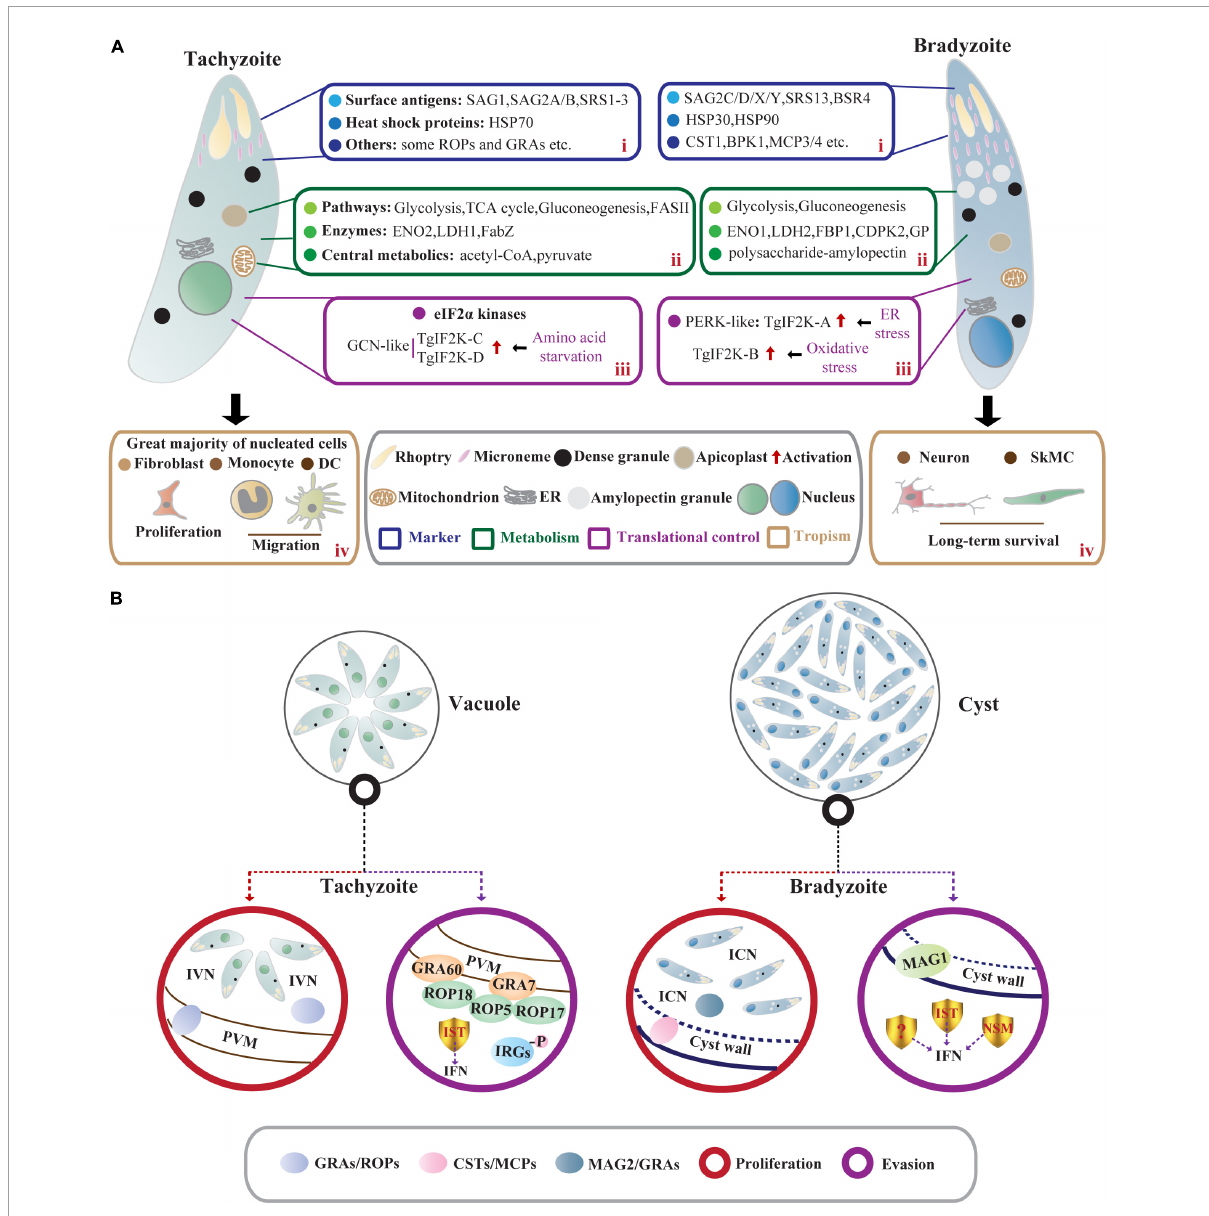
FIGURE1 Comparisons of T. gondii acute stage and chronic stage in intermediate hosts. (A) Characteristics of tachyzoites and bradyzoites. In intermediate hosts, the rapidly dividing tachyzoites and slowly growing bradyzoites differ in many characteristics, including (i) stage-specific markers; (ii) metabolism; (iii) translational control; and (iv) tropism. (i) The stage-specific proteins contain SAGs and HSPs as well as some membrane-associated proteins exported to PV membrane (ROPs and GRAs) and cyst wall (CSTs and MCPs). (ii) Central carbon metabolism (the glycolytic pathway and the tricarboxylic acid cycle) and gluconeogenesis allow intracellular tachyzoites to survive promiscuously. However, bradyzoites lack a functional TCA cycle and respiratory chain but accumulate abundant polysaccharide–AG in the cytoplasm. (iii) The eIF2 α phosphorylation regulated by TgIF2K-A and TgIF2K-B leads to the reprogramming of the transcriptome and initiation and maintenance of parasite latency. TgIF2K-C and TgIF2K-D have been reported to protect tachyzoite against amino acid starvation. (iv) The tachyzoites can infect almost all nucleated cells especially fibroblasts, and hijack monocytes and DCs to promote their systemic dissemination. These tachyzoites can spontaneously differentiate into bradyzoites, forming semi-dormant cysts in brain cells (neurons) and muscle cells (SkMCs). (B) The proliferation and immune evasion of parasites. In tachyzoite, ROPs and GRAs secreted from rhoptries and dense granules contribute to the formation of PVM and IVN. Meanwhile, IST-dependent suppression of interferon signaling and ROP18 virulence complex